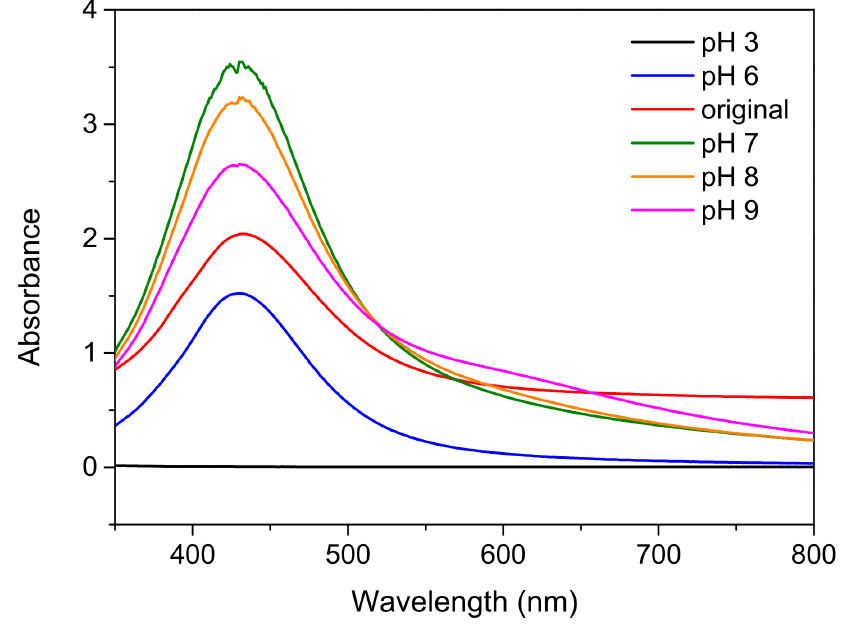
Figure 8. UV-Vis analysis results obtained for samples prepared at various pH